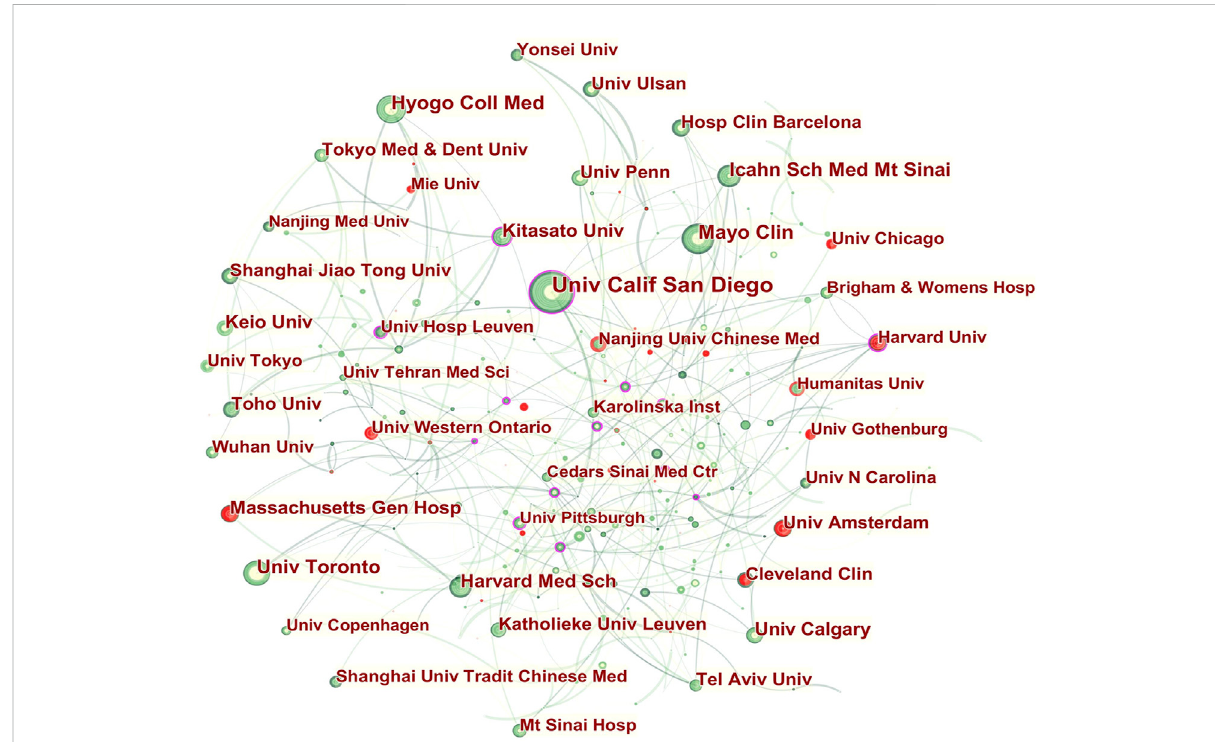
FIGURE 3 Network of institutions engaged inUCresearch. Note: An individual node represents an institution on thenetwork map. The greater thearea of the node, the more publications there are. The thicker the curved line connecting nodes, the more frequent their co-occurrence, as this indicates a collaborative relationship. An isolated node with no link lacks all collaboration. When a node has a high betweenness centrality ( > 0.1) (i.e., when it is connected to more than 10% of the other nodes), it exerts signi fi cant in fl uence over others as it controls most resources within their collaborativenetworks(Coboetal.,2011).Thepresenceofapurplerimalsoindicatesahighdegreeofbetweennesscentrality.Redtreeringsindicate bursts of citation, indicating high scholarly activity. Red tree rings with a greater thickness show a greater burst for a corresponding node.